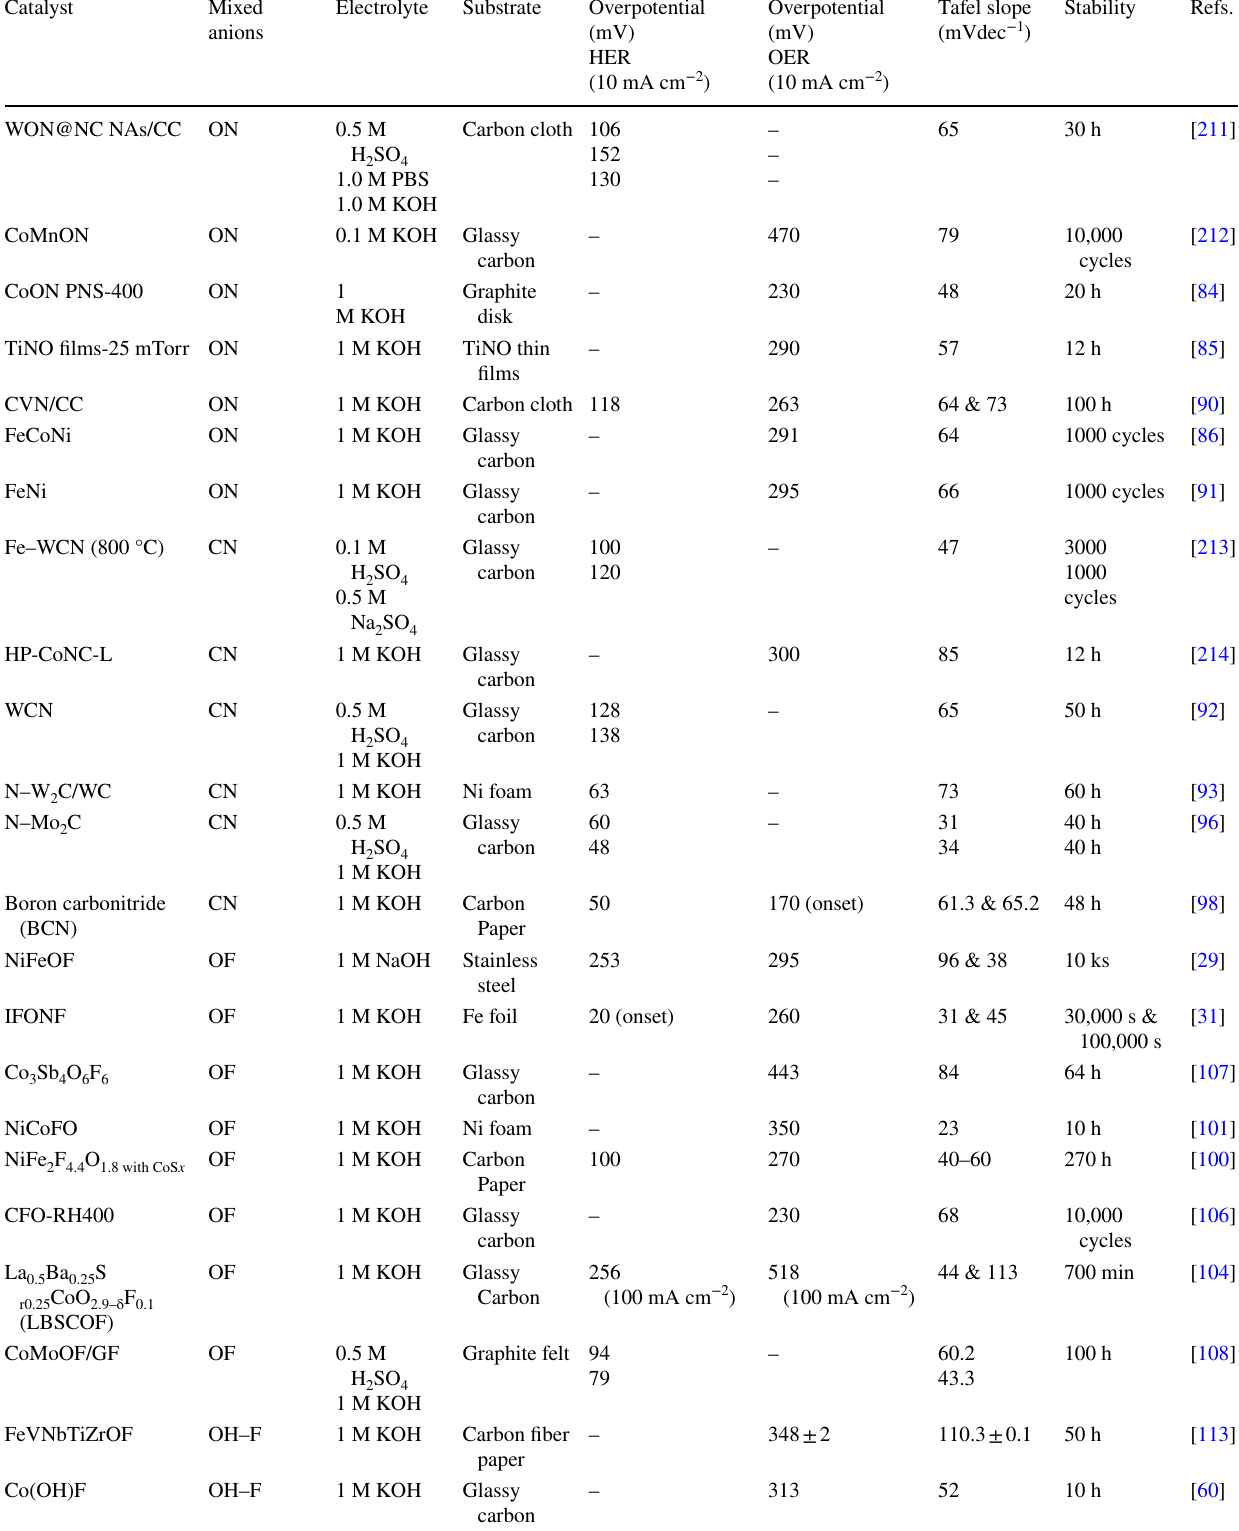
Table 1 Comparison of the OER and HER performance of typical mixed nitrides, halides, and phosphides-based electrocatalysts